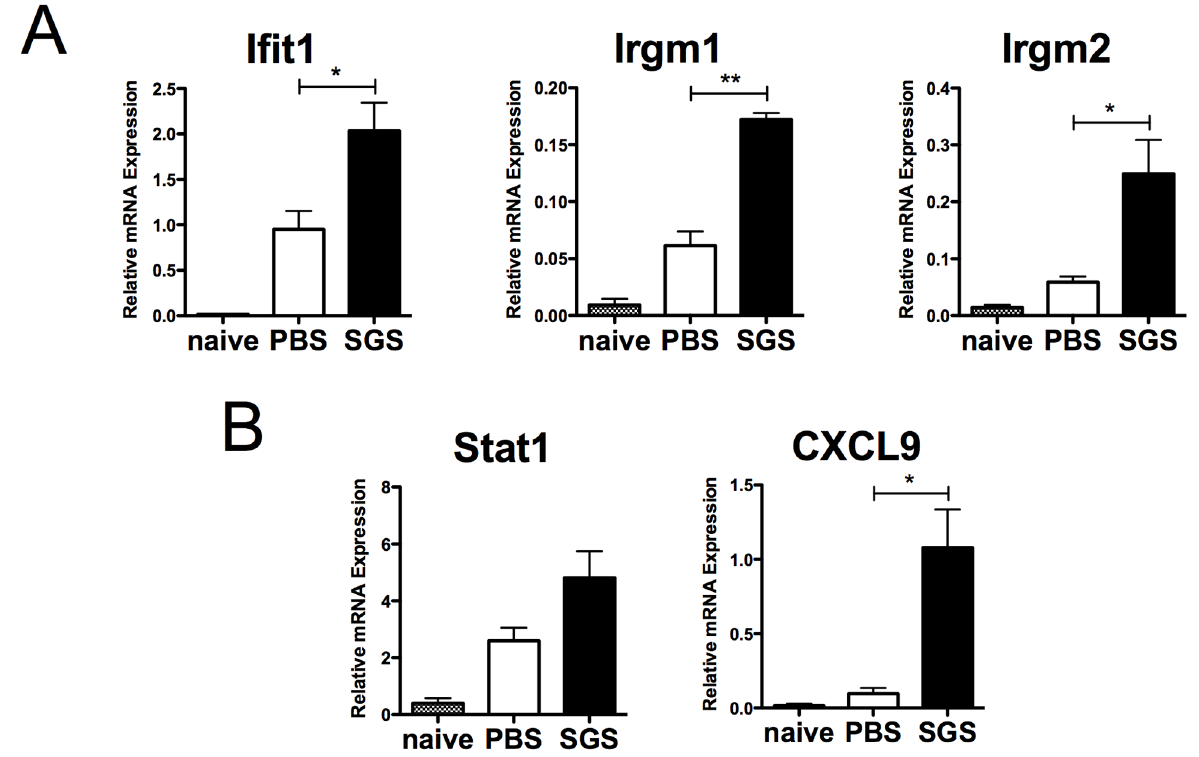
Figure 2. IFN-inducible genes are upregulated in response to SGS pre-immunization. BALB/c mice were inoculated 3 times in the right ear every 2 wks with Lu. intermedia SGS or PBS and then challenged in the left ear 2 wks later with Lu. intermedia SGS. The left ears were collected 2 wks after SGS challenge, homogenized and the expression of IFN-inducible genes such as (A) Ifit1, Irgm1 and Irgm2, and the expression of IFN-related genes like (B) Stat1 and CXCL9 was determined by real-time quantitative PCR normalized relative to HPRT mRNA levels. Similar analysis of ear pinna of naı¨ve mice that did not receive any injections and were not challenged with SGS is also shown. Data are an independent biological replicate to the microarray analysis; relative mRNA expression normalized to the housekeeping gene HPRT is presented as the mean + SEM with 3–5 mice per group; ** p , 0.005, * p , 0.05 by Student’s t -test.